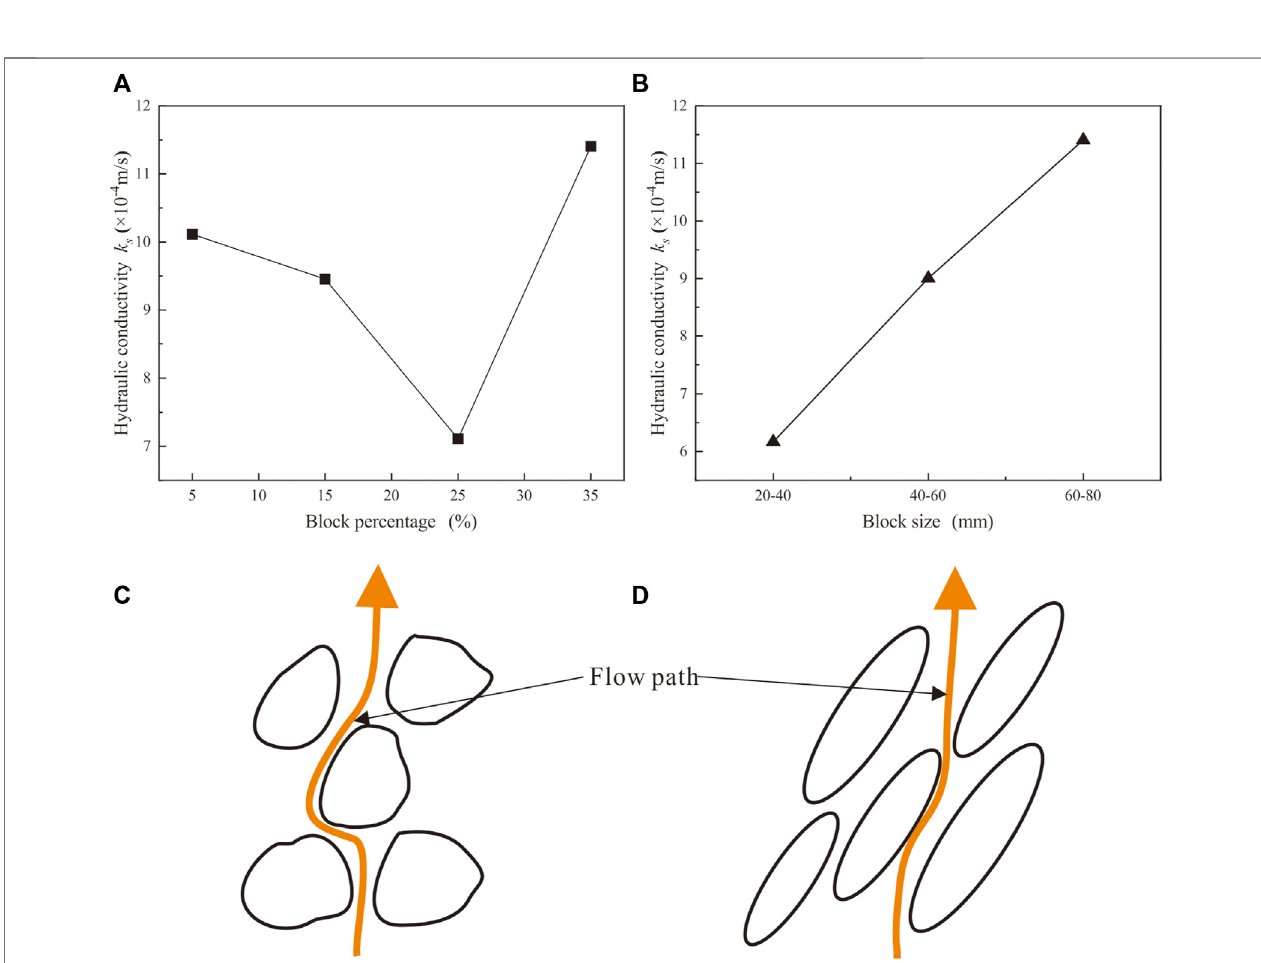
FIGURE11 | Hydraulicconductivityof phyllite bimrocks with different block percentages (A) and block sizes (B) considering theorientation ofblocks, and the fl ow paths in the homogeneous bimrocks (C) and the phyllite bimrocks (D) .